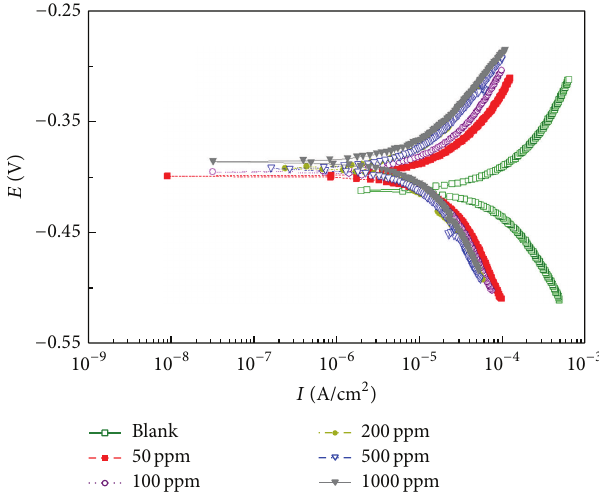
Figure 4: Typical polarization curves for corrosion of Q235A steel in 1M HCl in the absence and presence of different concentrations of